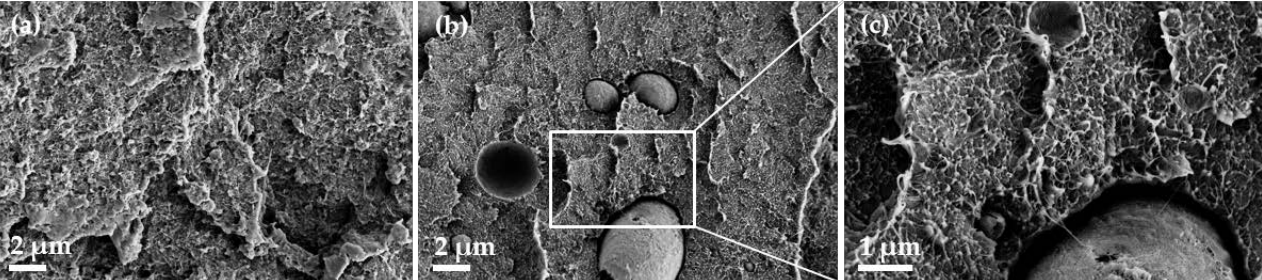
Figure 8. SEM image of PEEK composites with 1 wt% SWCNT ( a ) and PEEK with 1 wt% SWCNT + 3 wt% PVP ( b , c